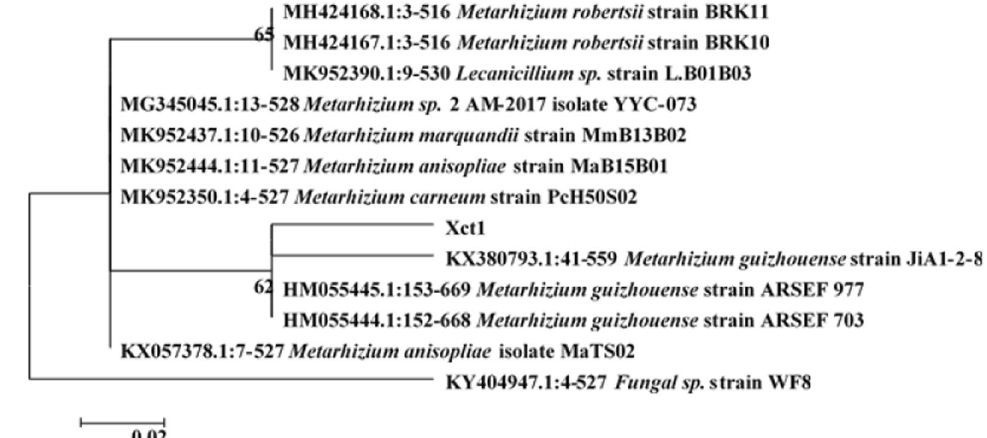
Fig. 3 Evolutionary tree of the Xct1 strain and Metarhizium anisopliae taxa based on rDNA-ITS sequences